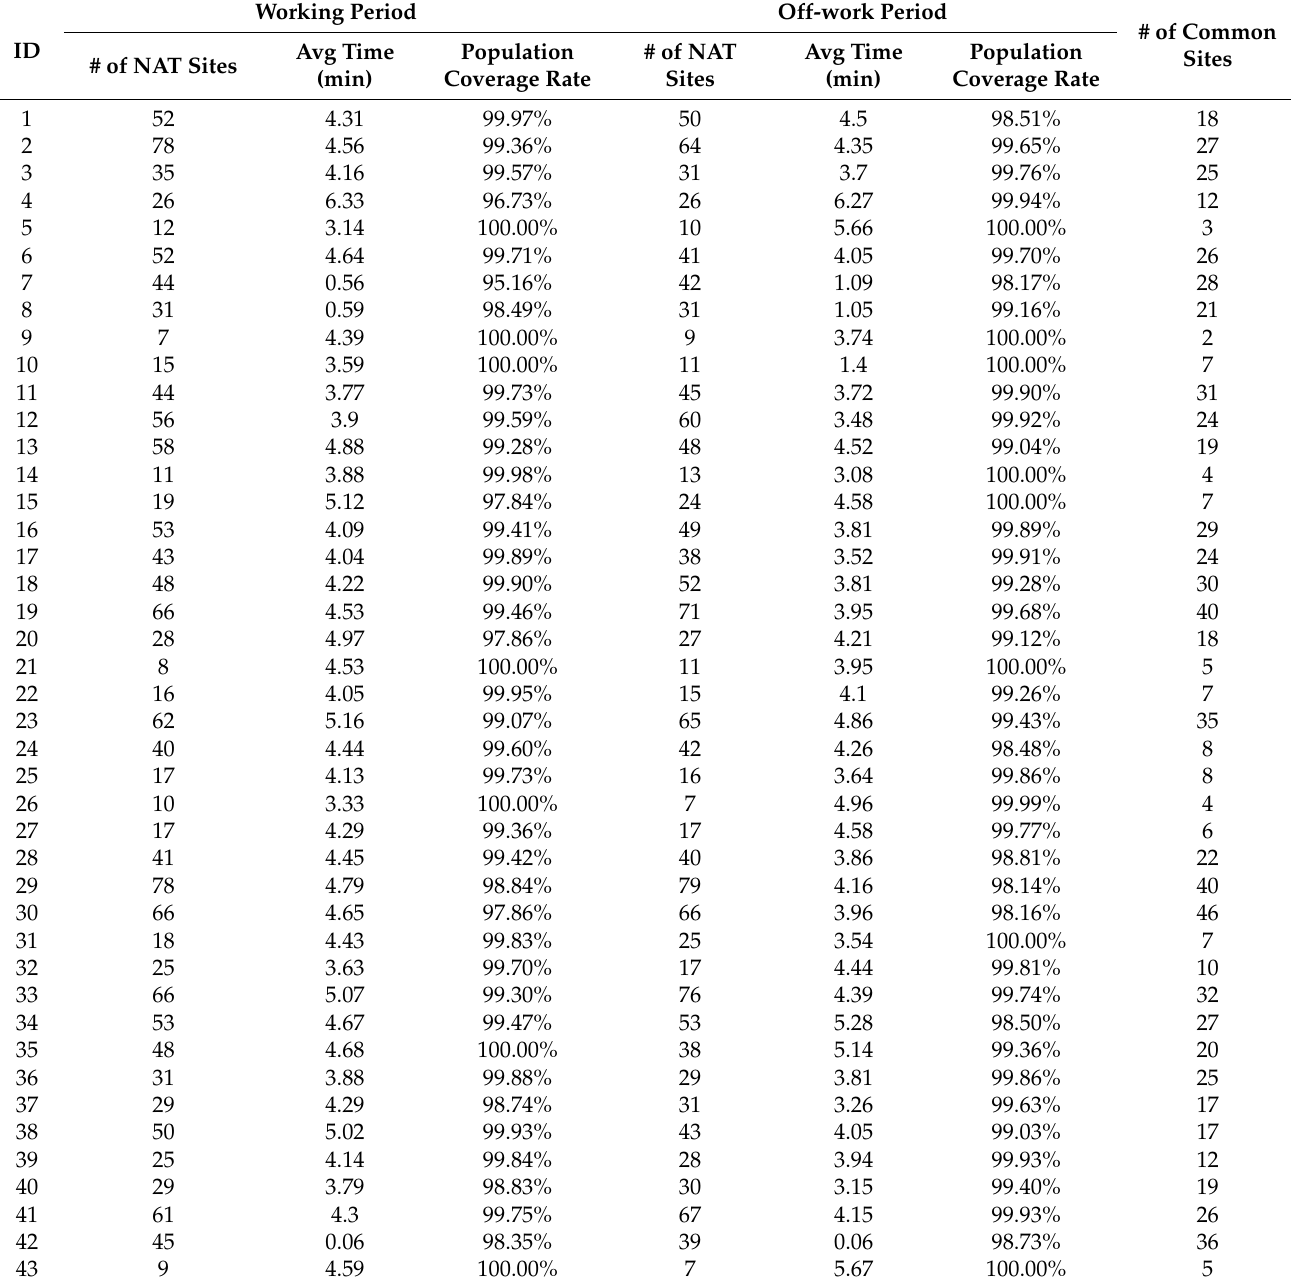
Table A1. Statistics of the NAT site scheme evaluated for each subdistrict in Shenzhen. Subdistricts are labelled by anonymous